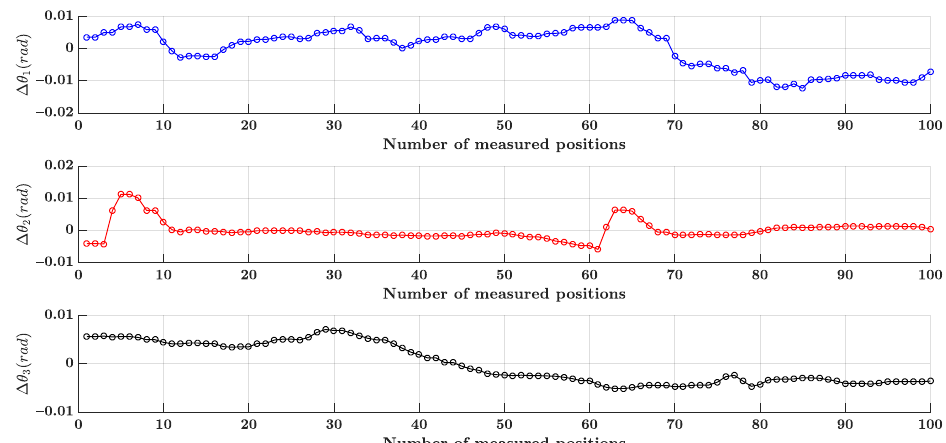
Figure 8. Difference between nominal and calibrated values of joint positions.